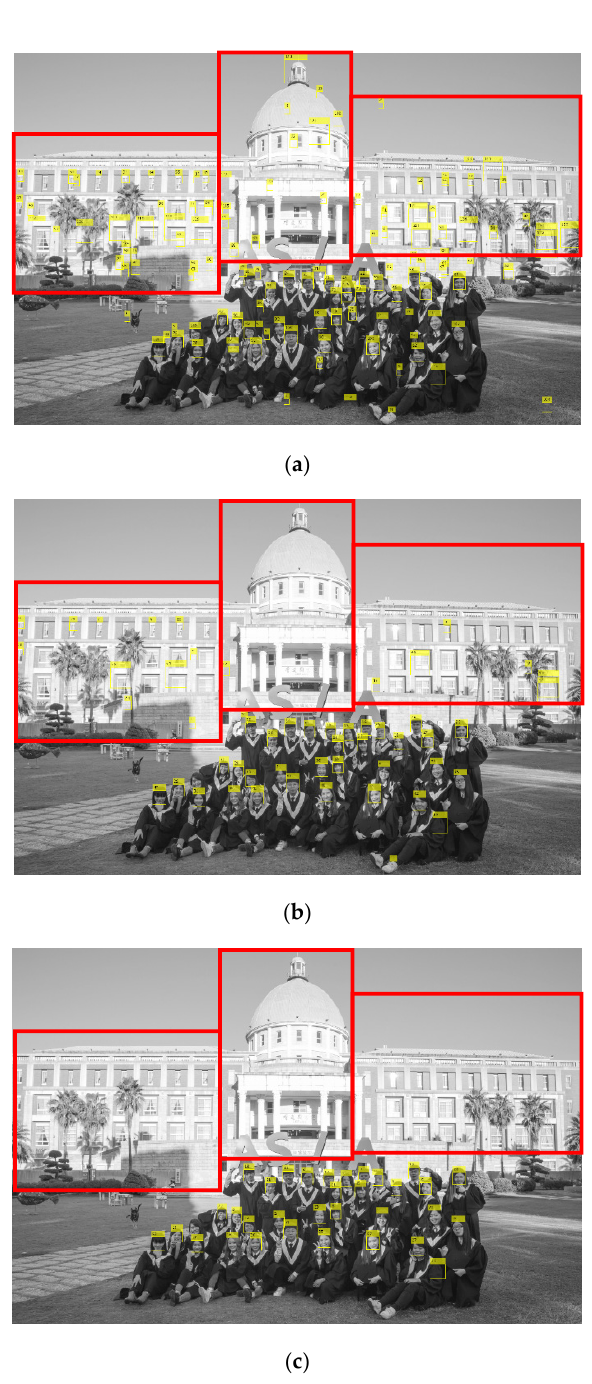
Figure 6. An example of human face detection results using the VJ algorithm with various merging thresholds: ( a ) merging threshold =1; ( b ) merging threshold = 2; ( c ) merging threshold = 5.